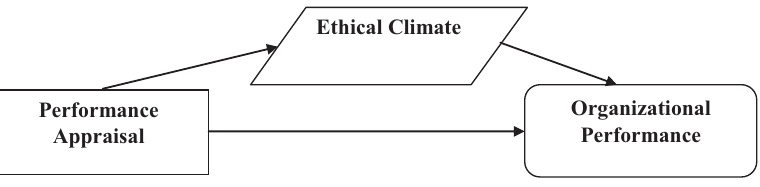
Figure 1. Research framework